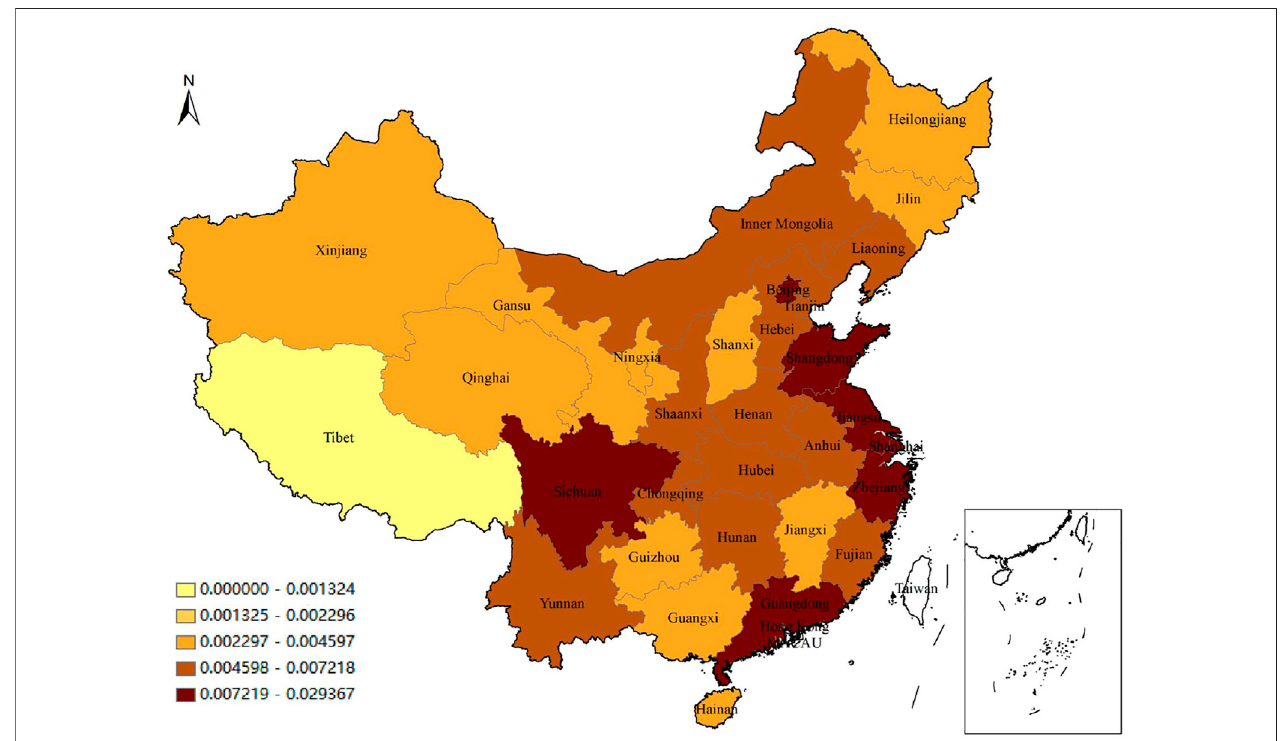
FIGURE 4 | Distribution map of digital economy index in